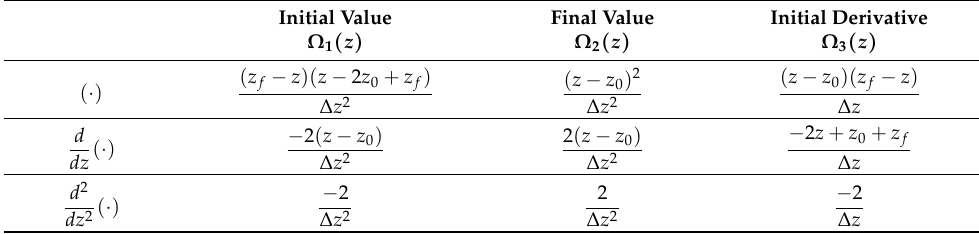
Table A5. Switching functions for a three constraints constrained expression, with two constraints on f and one on f (cid:48) , defined on domain of z ∈ [ z 0 , z f ] .